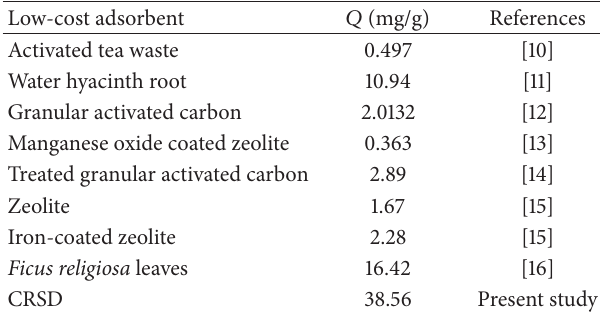
Table 6: Comparison of lead adsorption capacity of CRSD with other low-cost